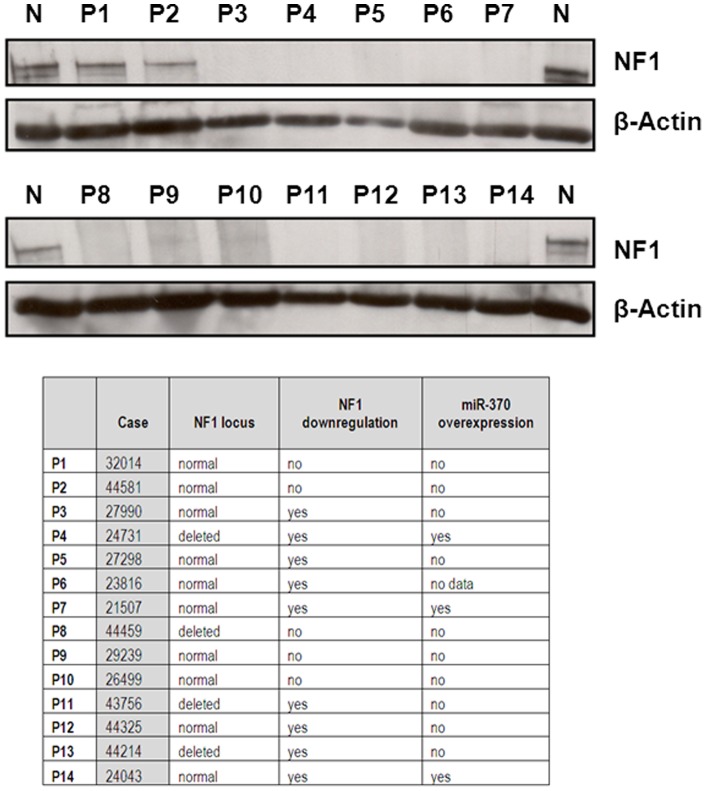
Western blot analysis of NF1 in 14 samples of patients with AML at diagnosis.Data about NF1 status and expression of miR-370 are shown. N: normal control; P: patient sample.